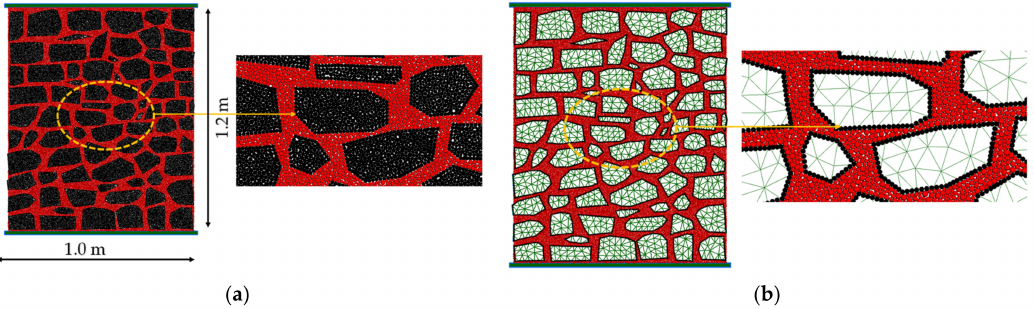
Figure 14. Numerical model of the rubble masonry walls tested in [22]: ( a ) all-particle model (DEM); ( b ) proposed hybrid model